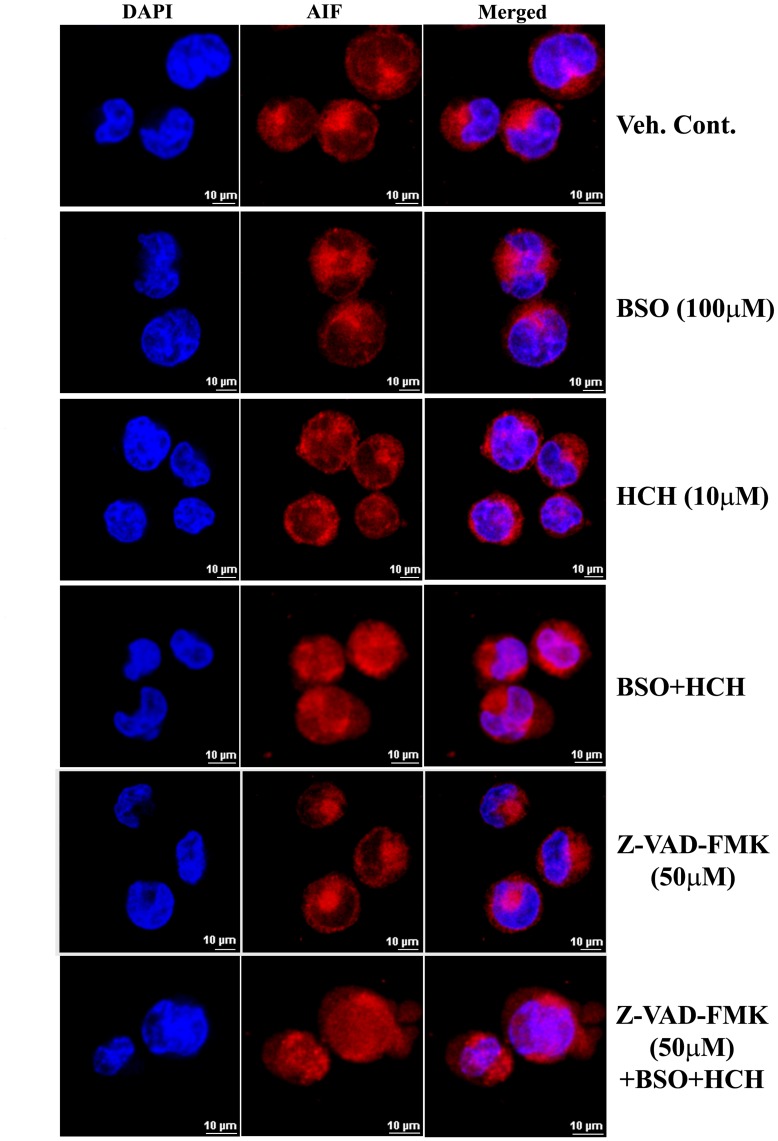
Combination of BSO and HCH induces AIF translocation in caspase-independent manner.K562 cells were treated as indicated and processed for confocal microscopy as stated in Materials and Methods. Scale bar, 10 µm.